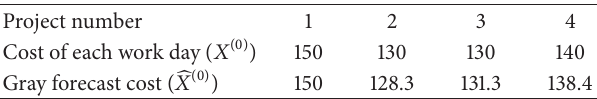
Table 2: Comparison between the original value and the forecast value.